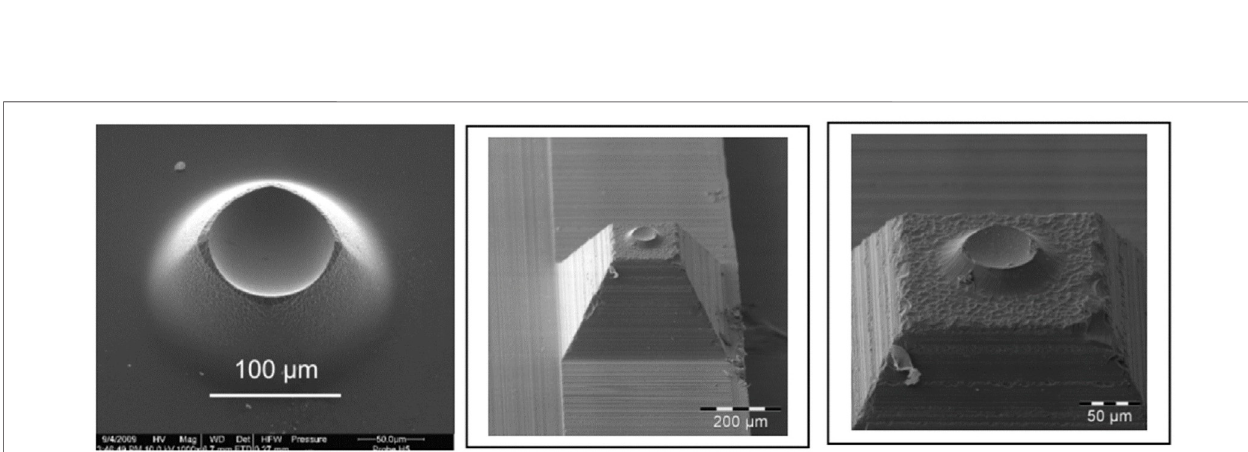
Frontiers in Materials |